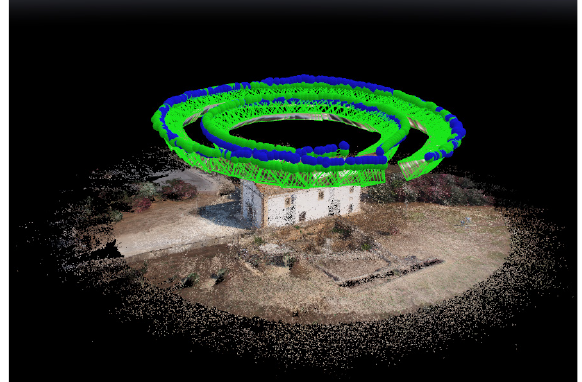
Table 12. Number of points for each scan.